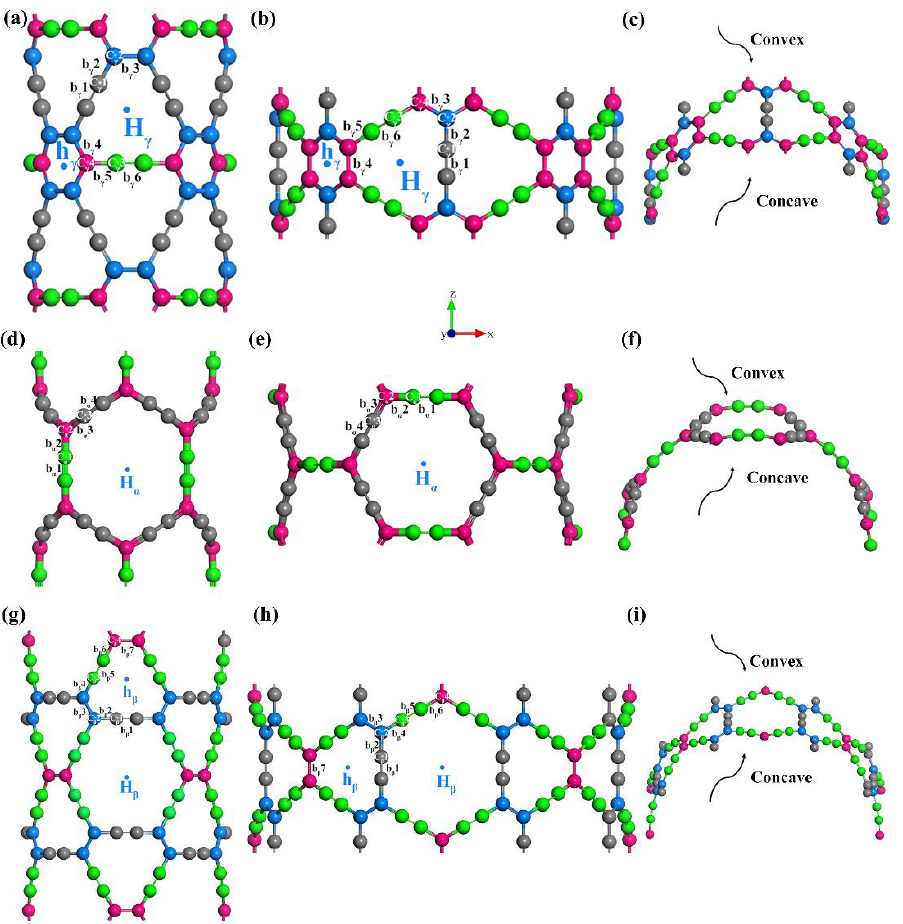
Figure 2. Illustration of possible adsorption sites for a single Na atom on ( a ) ( n , 0)- γGyNTs, ( b ) ( n , n )- γGyNTs, ( d ) ( n , 0)- αGyNTs, ( e ) ( n , n )- αGyNTs, ( g ) ( n , 0)- βGyNTs, and ( h ) ( n , n )- βGyNTs. The convex and concave positions of ( c ) γGyNTs, ( f ) αGyNT, and ( i ) βGyNTs (Pink: sp 2 -C with large curvature; blue: sp 2 -C with small curvature; green: sp-C with large curvature; grey: sp-C with small curvature).